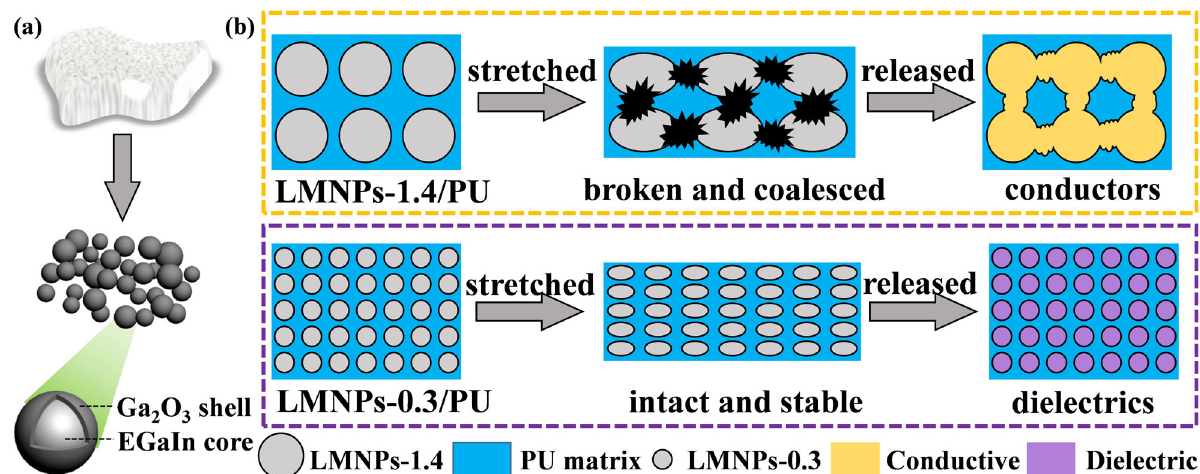
Fig. 1 Design of LM-based stretchable conductors and dielectrics. a The LMNPs preparation process and core-shell structure. b Schematic illustration of morphology changes of LMNPs-1.4 and LMNPs-0.3 applied in stretchable conductors and dielectrics. LMNPs-1.4/PU or LMNPs- 0.3/PU samples are obtained by mixing LMNPs-1.4 or LMNPs-0.3 with corresponding PU,